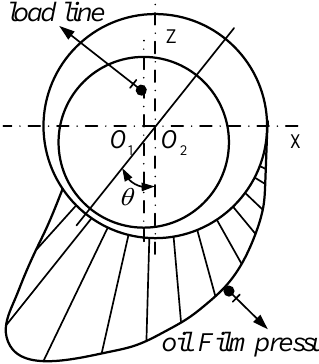
Figure 11. Schematic diagram of the oil pressure without surface waviness.